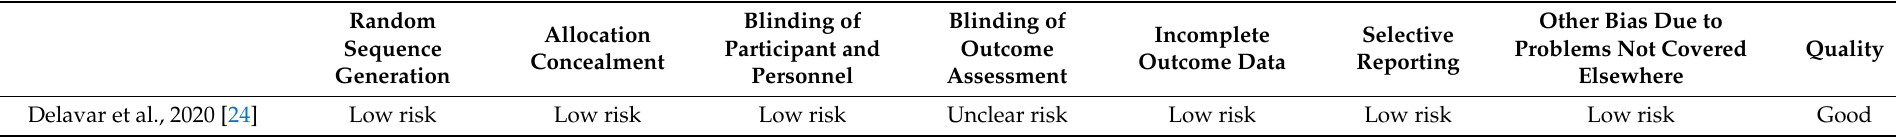
Table 6. Summary of quality assessment of the included studies using Cochrane’s collaboration tool for assessing the risk of bias in randomized